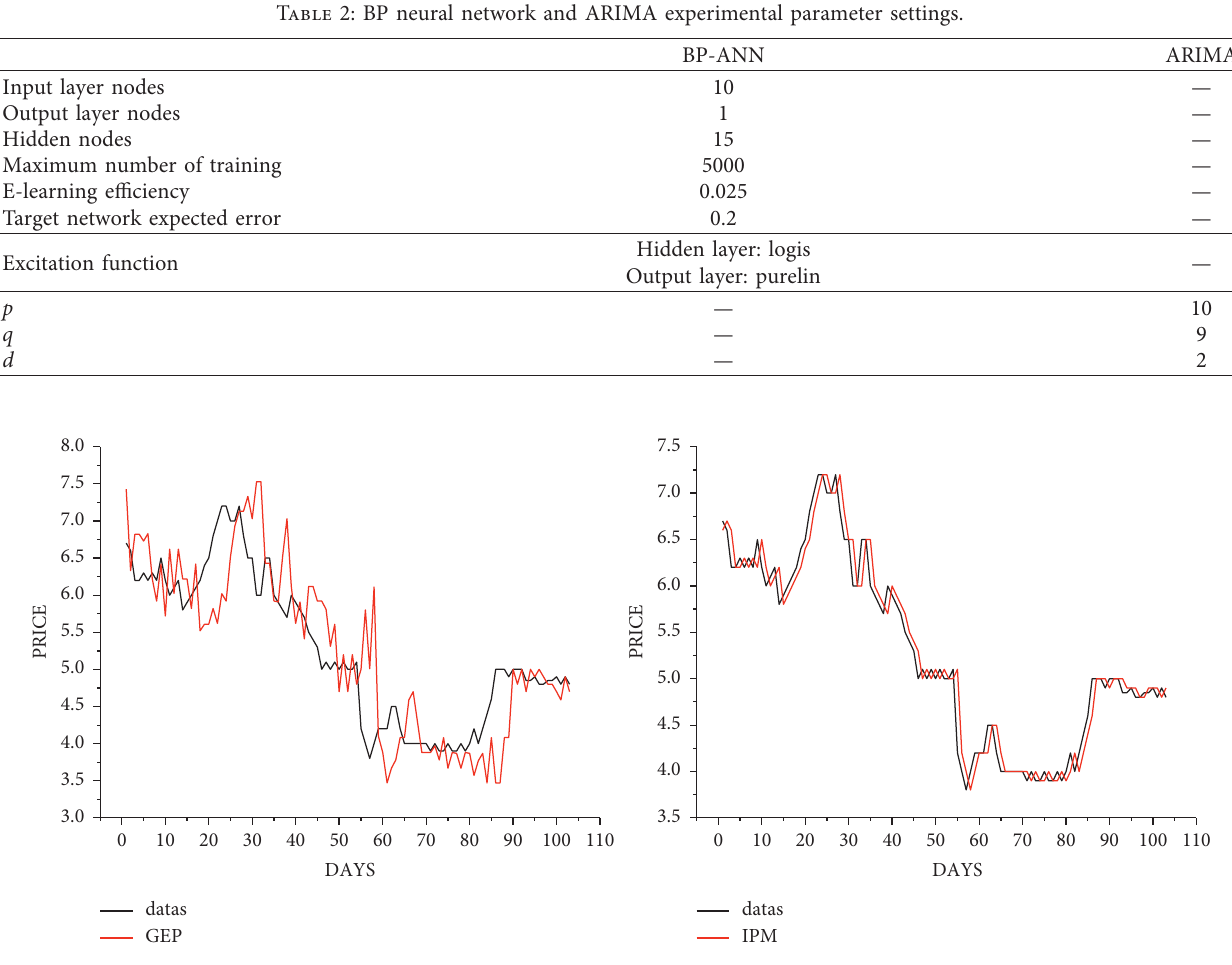
Table 2: BP neural network and ARIMA experimental parameter settings.